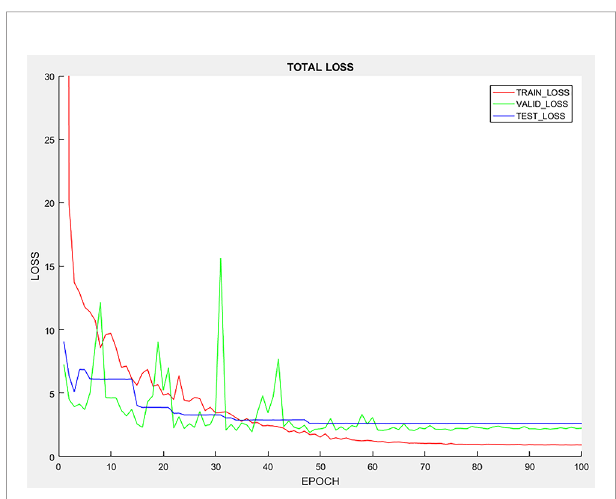
FIGURE 2 | Learning curve of the prediction model.